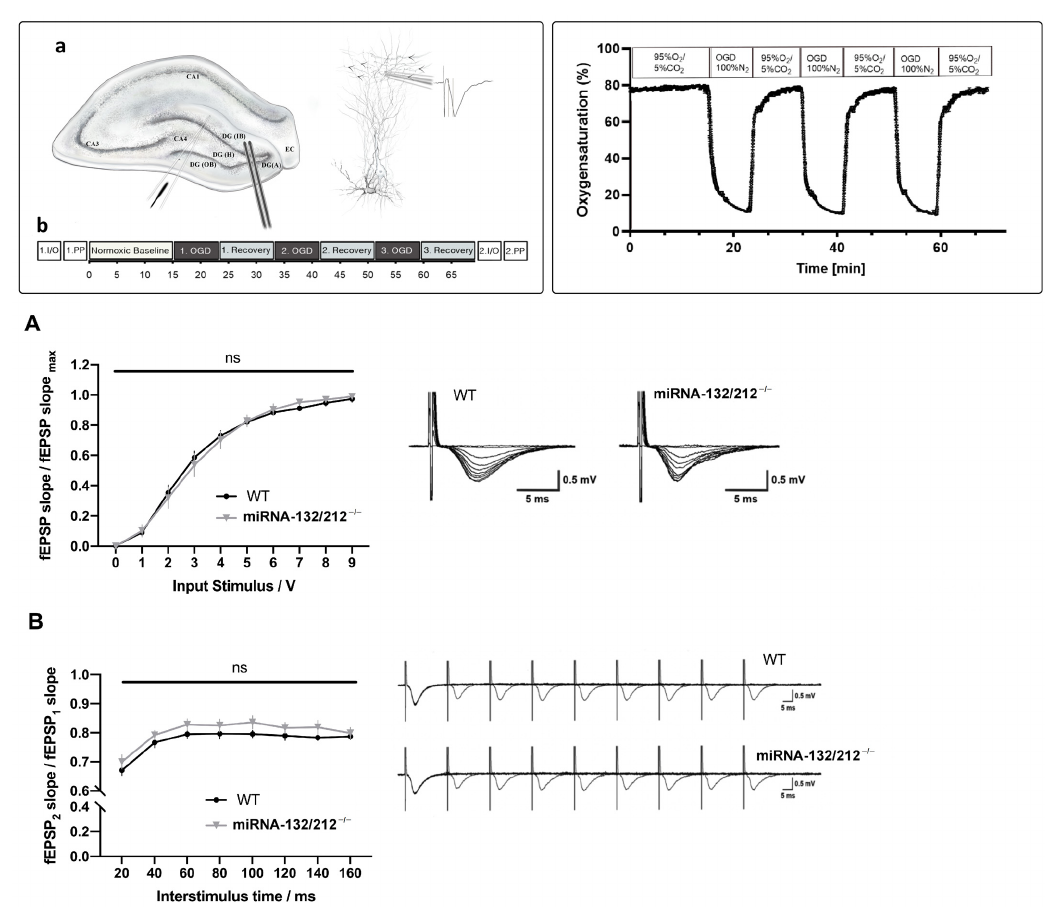
Figure 1. miRNA-132/212 deletion did not alter basal synaptic transmission and paired-pulse inhibition (PPI) in the hippocampal dentate gyrus. Inset (1) Schematic representation of the electrophysiological recording setting. ( a ) Diagram of a hippocampal slice, with a schematic representation of the histological layering of the dentate gyrus (middle inset). The lower left inset depicts the positioning of the stimulating and recording electrode. The right inset illustrates the positioning of the recording electrode in relationship to the dendritic layer of the neuronal granule cells and a representation of a recorded field excitatory postsynaptic potential (fEPSP). Arrows denote the flow of inputs from the perforant pathway. ( b ) Schematic synthesis of the experimental protocol for electrophysiological recordings. CA 1–4: Cornu Ammonis areas 1–4, DG: Dentate gyrus, (A): Apex, (H): Hilus, (IB): Inner Blade, (OB): Outer Blade, EC: Entorhinal cortex, fEPSP: field excitatory postsynaptic potential, I/O: Input Output, PP: Paired pulse stimulation, OGD: Oxygen Glucose Deprivation. Inset (2) Temporal course of the oxygen saturation measured in the recording chamber during repeated episodes of OGD. Superfusion of the recording chamber with 100% N2 gassed OGD aCSF led to a sharp drop of oxygen saturation below 20% within 3 min bottoming at less than 12% oxygen saturation at the end of the OGD period. Reperfusion with carbogenated aCSF (95%O 2 /5%CO 2 ) increased the oxygen saturation back to values greater than 60% oxygen saturation in less than 1 min. Graph derived from optode recorded oxygen saturation data of three independent recording days. aCSF: artificial cerebrospinal fluid, OGD: Oxygen Glucose Deprivation. ( A ) I/O curves generated by plotting normalized fEPSP slope changes versus increasing pulses of input stimulation voltages obtained in WT ( n = 7) and miRNA-132/212 − / − mice ( n = 6) hippocampal slices. Two-way repeated measures ANOVA did not reveal statistically significant differences between genotypes before the implementation of the OGD treatment. Right inset: Representative raw fEPSP traces recorded from hippocampal slices obtained from WT mice (left) and miRNA-132/212 − / − mice (right) in response to increasing stimulus intensities show no apparent differences. ( B ) PPI ratios (second pulse/first pulse) plotted against inter-pulse intervals from 20 to 160 ms. No statistically significant differences (“ns” in the figure) between genotypes were detected by two-way repeated measures ANOVA. Right inset: Depiction of representative raw fEPSP traces obtained during the PPI protocol described in the materials and methods section in the dentate gyrus of WT (upper trace) and miRNA-132/212 − / − mice (lower trace), without macroscopic differences. Data is presented as mean ± SEM. fEPSP: field excitatory postsynaptic potential, I/O: Input Output, OGD: Oxygen Glucose Deprivation, PPI: Paired Pulse